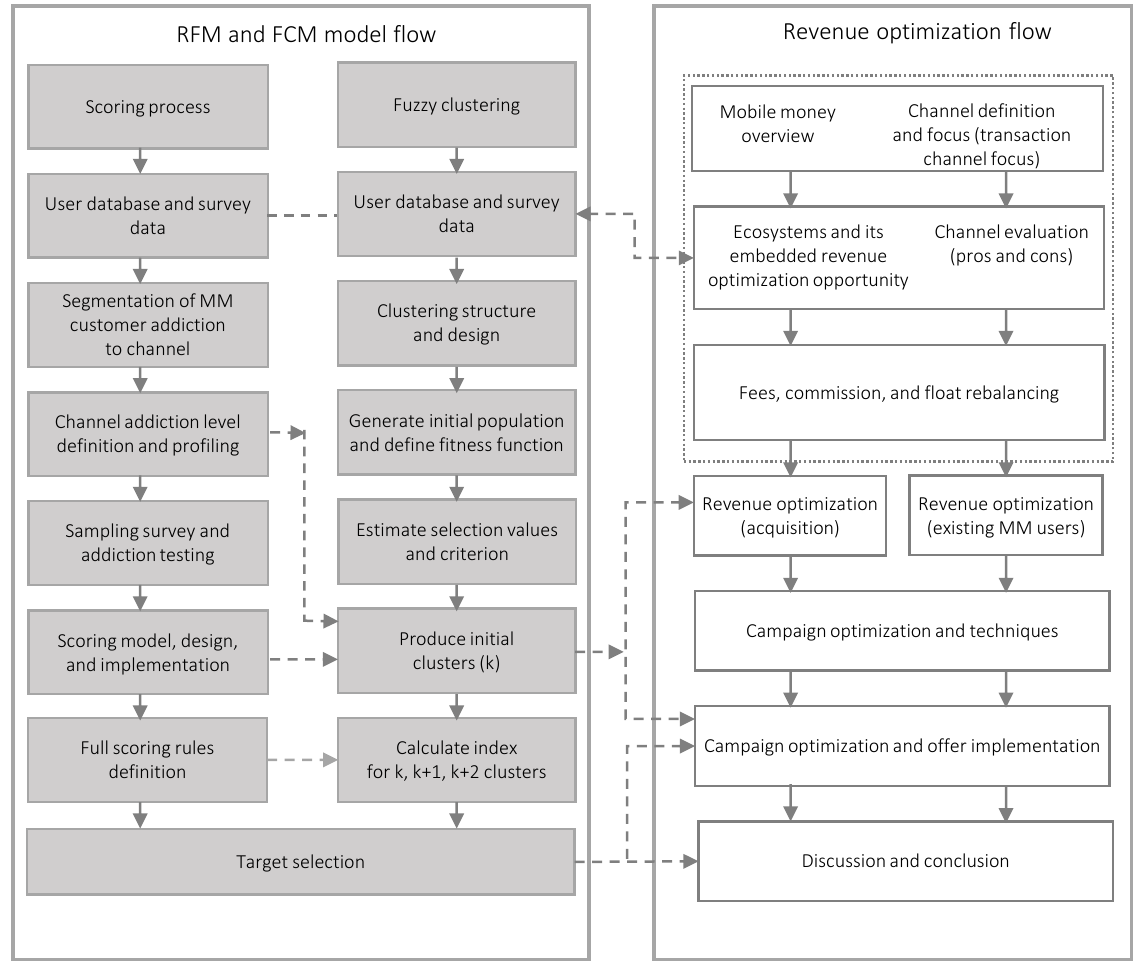
Figure 1. Target selection models – fuzzy c-means (FCM) and